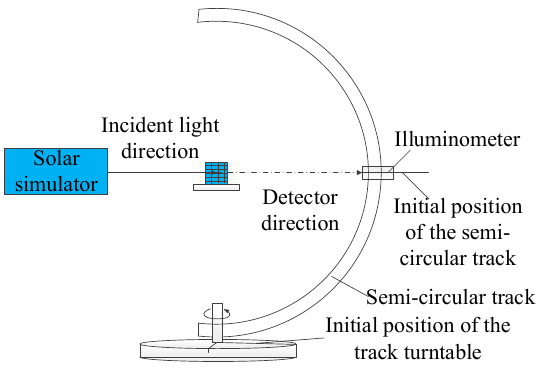
Figure 9. The sketch of calibration of initial position of the detector.